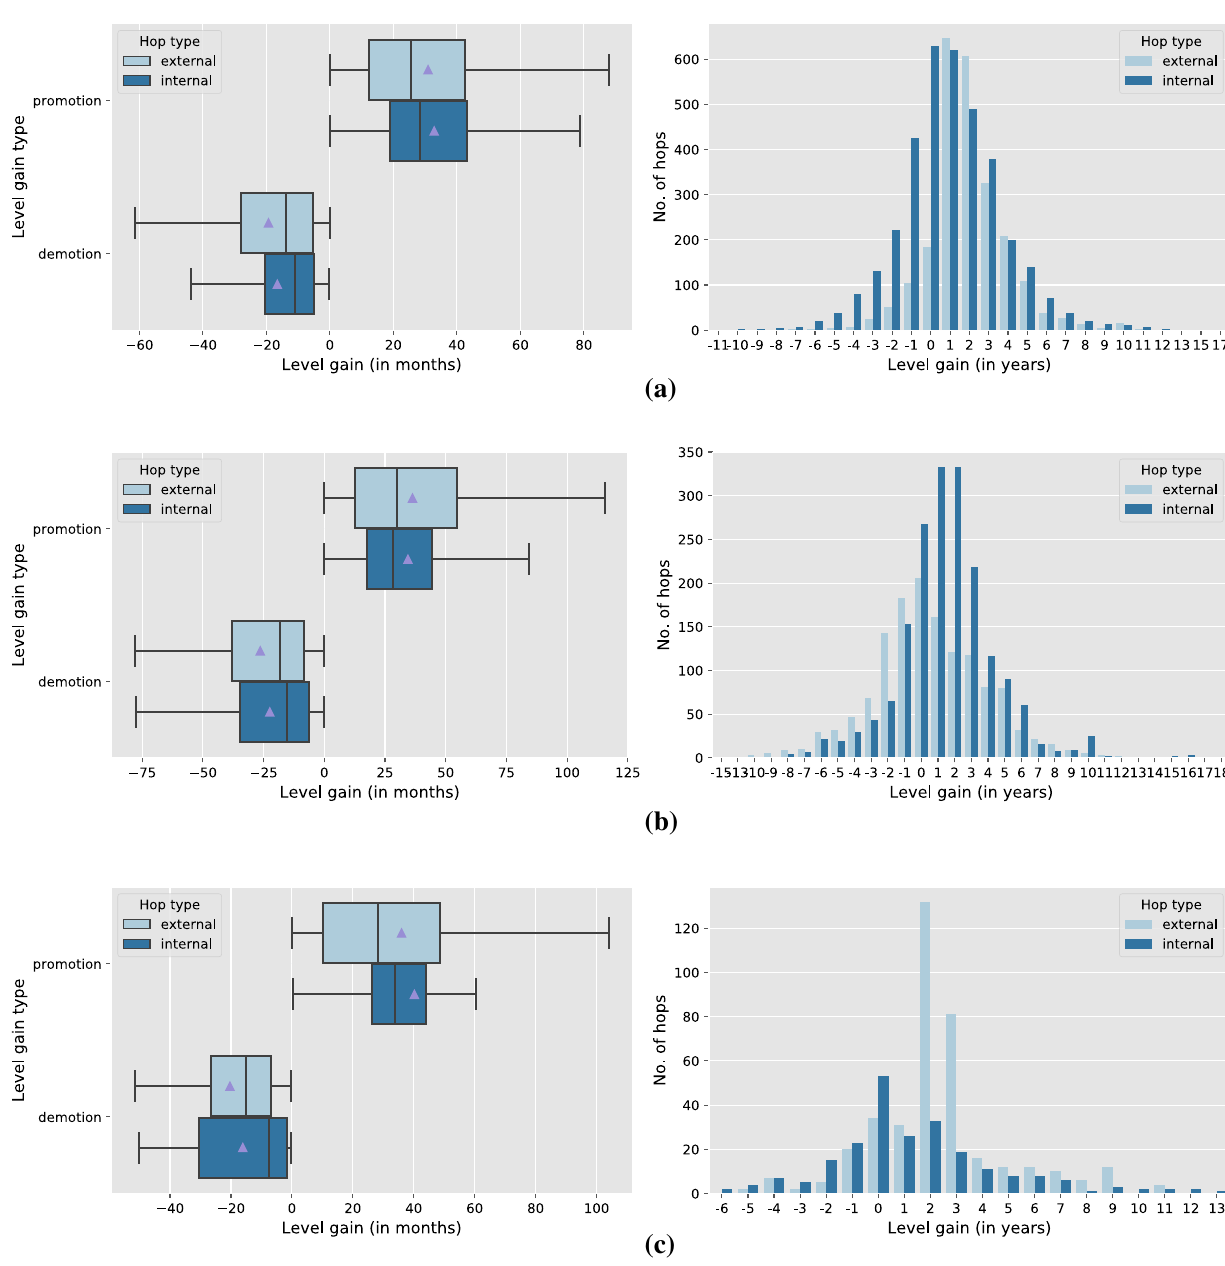
Fig. 11 Comparison of level gains for different hop types. a Singapore. b Switzerland. c Hong